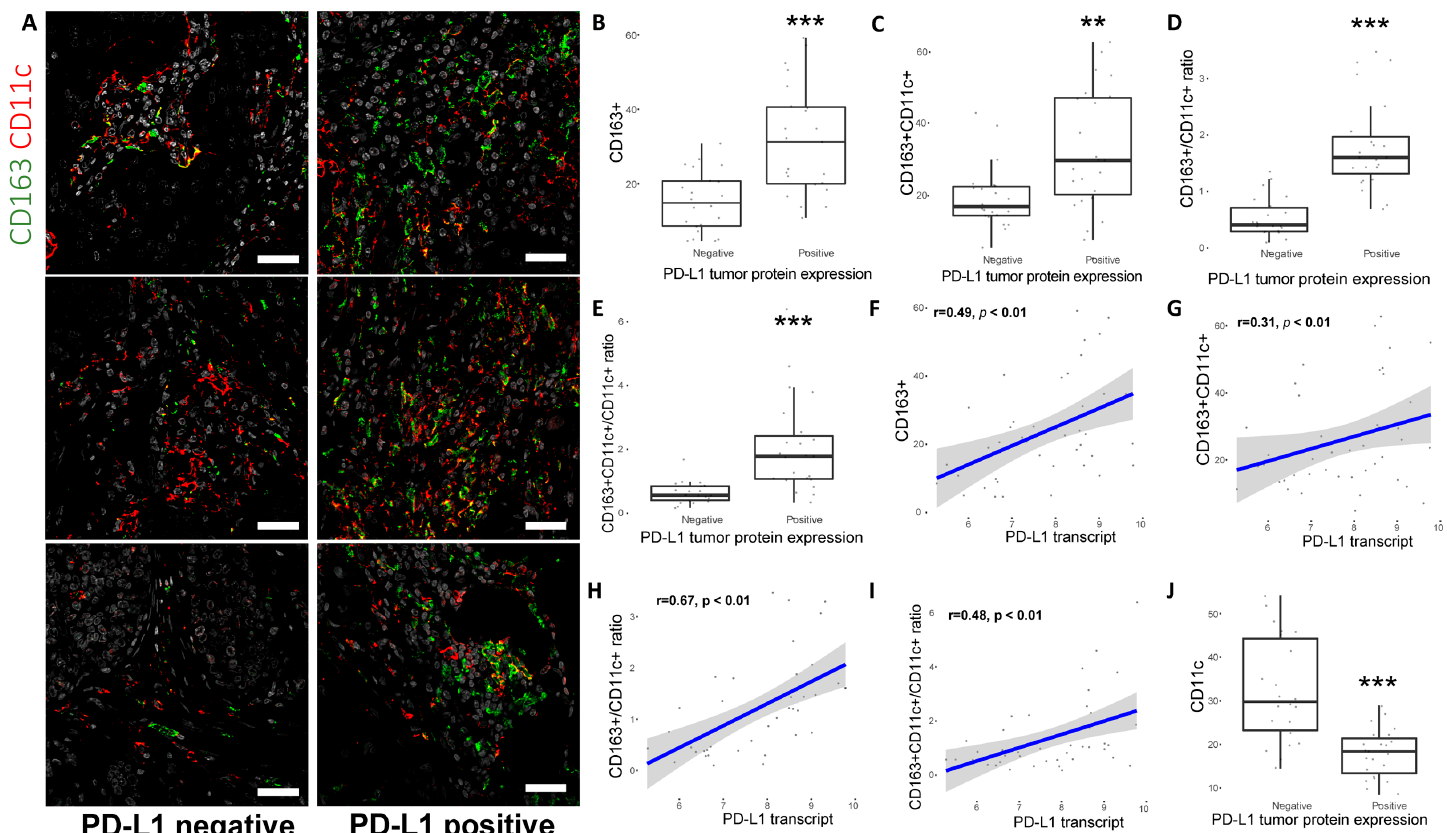
Figure 5. Pro-tumoral TAM phenotype correlates with PD-L1 expression levels in human breast cancer patients. ( A ) Double immunofluorescence staining with markers for antigen presenting cells such as M1-like TAMs (CD11c: red) and pro-tumoral M2-like TAMs (CD163: green) macrophages was performed in patients with PD-L1 positive ( n = 23) and PD-L1 negative ( n = 22) expression in tumor cells. Scale bar, 100 um. Correlations of PD-L1 protein expression in tumor cells with percentage of CD163 + cells ( B ), percentage of CD163 + CD11c + cells ( C ), CD163 + /CD11c + ratio and CD163 + CD11c+/CD11c+ ratio (M2-like subtype 2 versus M1-like phenotypes) ( D – E ) . ( F – I ) The same percentages and ratios were also positively correlated with PD-L1 transcript levels. An inverse correlation was noted between CD11c + cells with PD-L1 positive tumor protein expression ( J ). Wilcoxon-Mann-Whitney test and Spearman’s rank correlation coefficient were used (* p < 0.05; ** p < 0.01; *** p < 0.001).